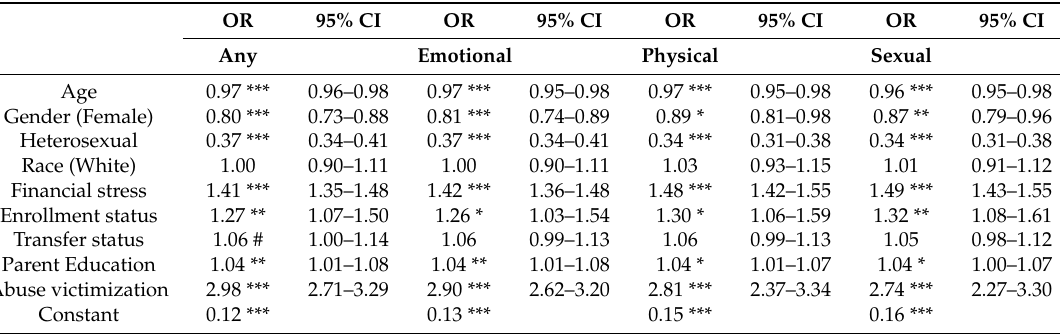
Table 4. Summary of logistic regressions for the association between violence victimization and suicidal